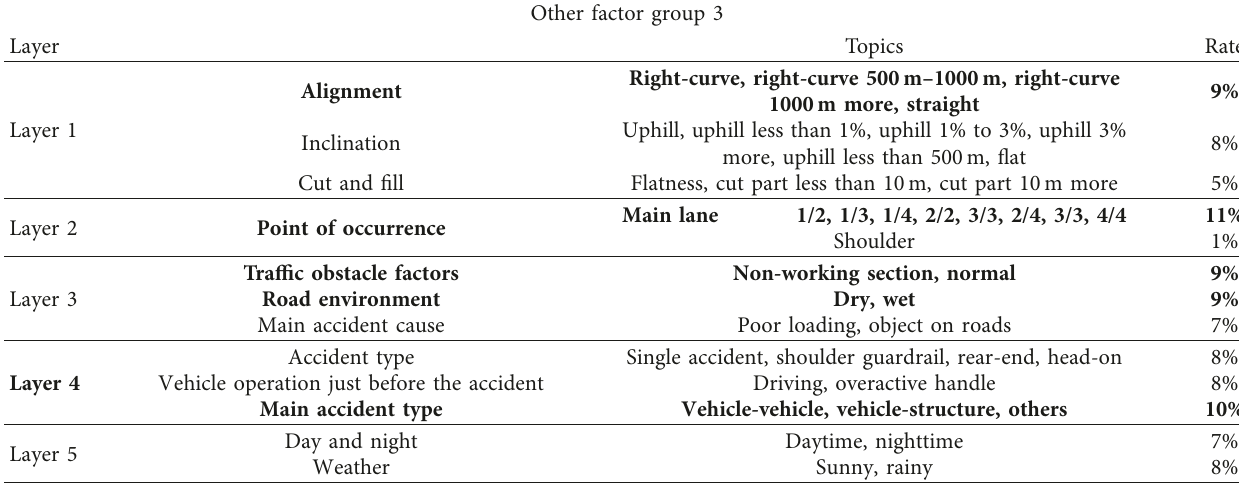
Table 11: Other factor topic modeling group 3.